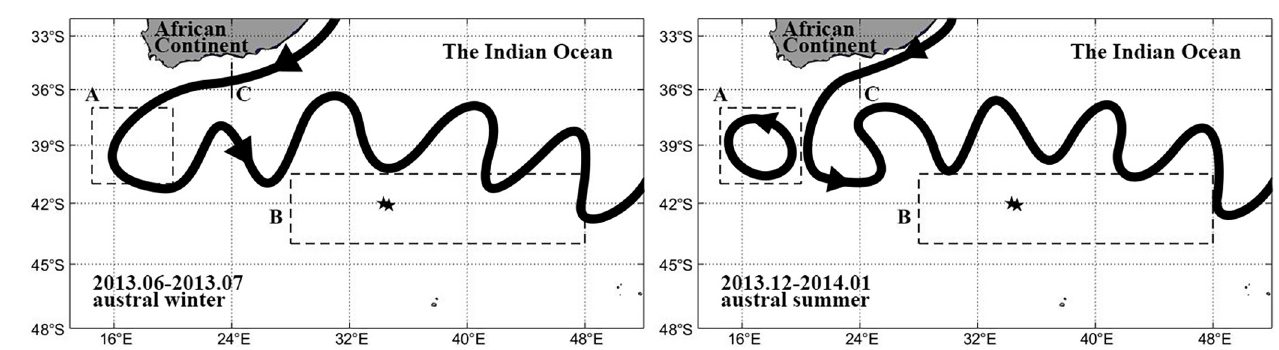
Fig 1. The general flow direction of Agulhas Current in winter and summer. Box A is at the Agulhas retroflection region. Box B is located at the south of the Agulhas Current. Line C is at the point where the Agulhas Current out of the African continent before entering the retroflection region. The black pentagrams are the location of the Argo.